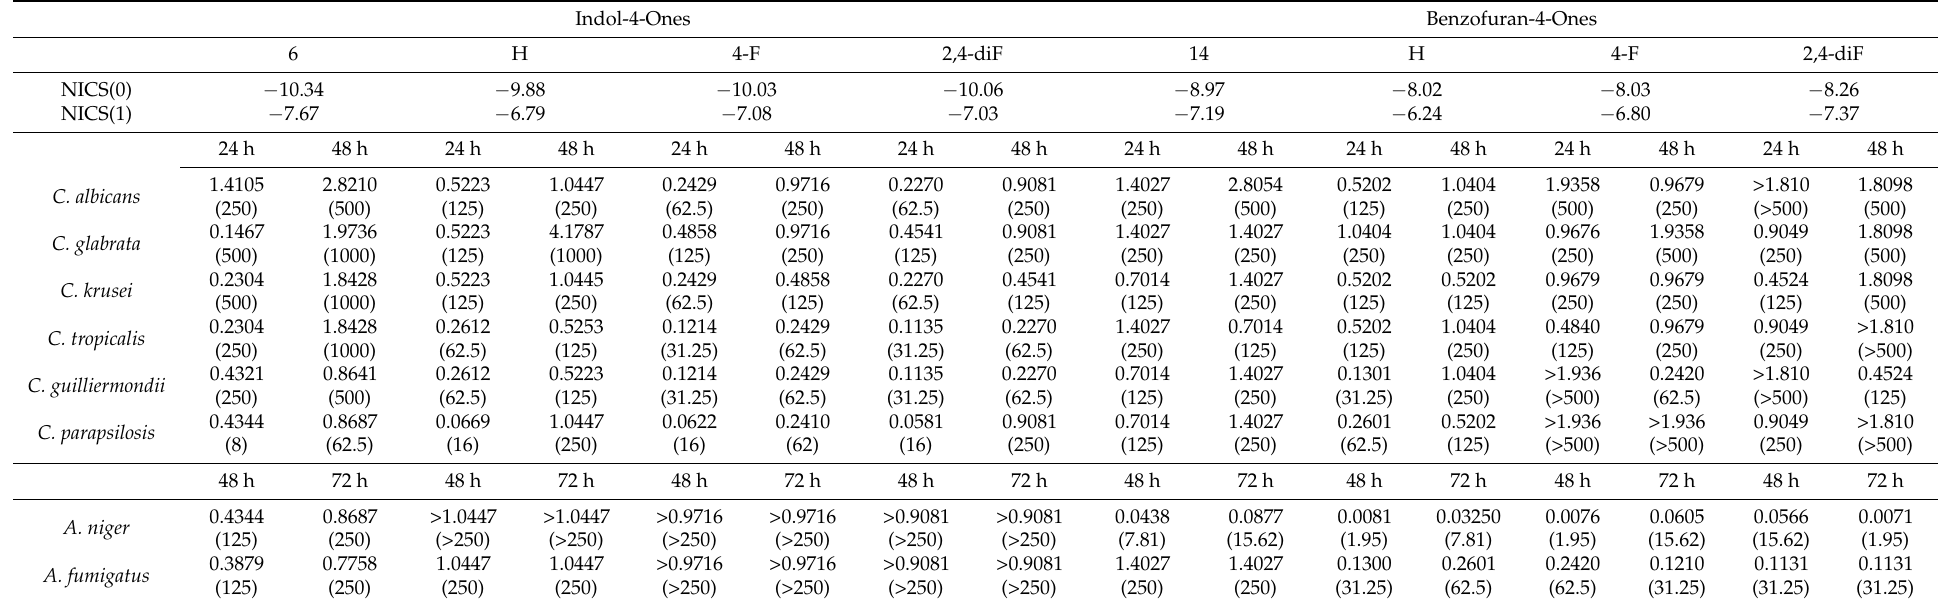
Table 6. Summary of NICS and MIC values in vitro of indol-4-ones and